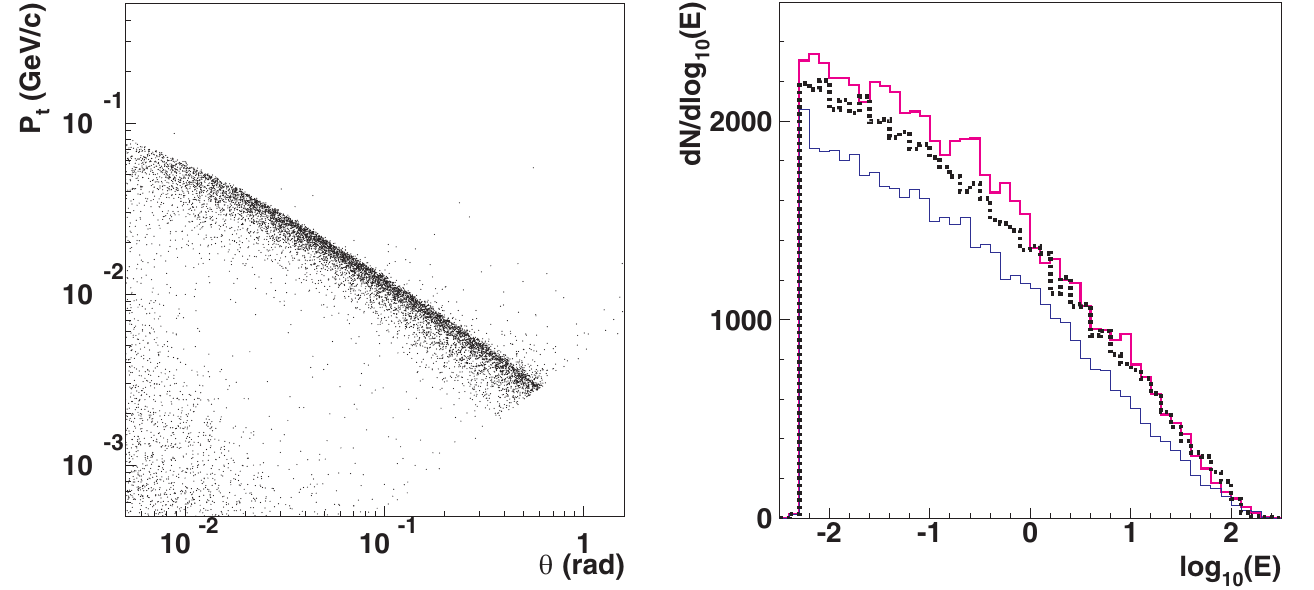
FIG. 4. Transverse momentum, P e (cid:8) from IPC processes modeled in CAIN .